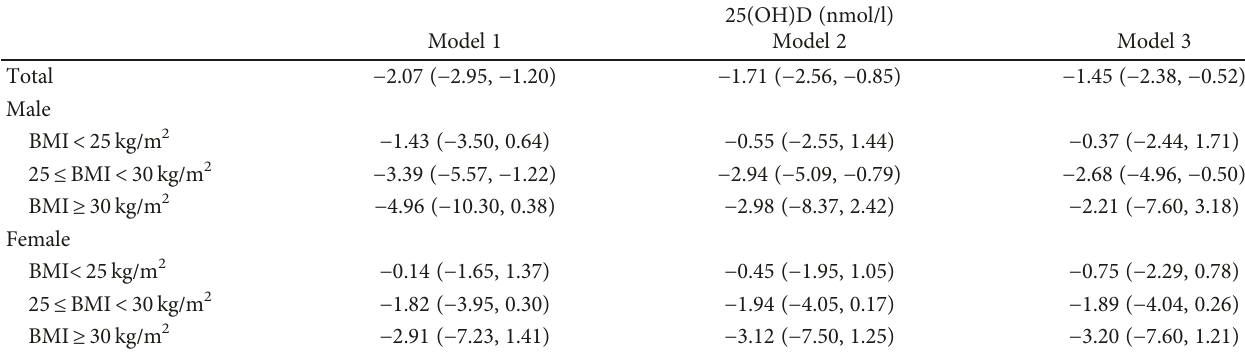
Table 4: Association of 25(OH)D with insulin resistance in males and females,